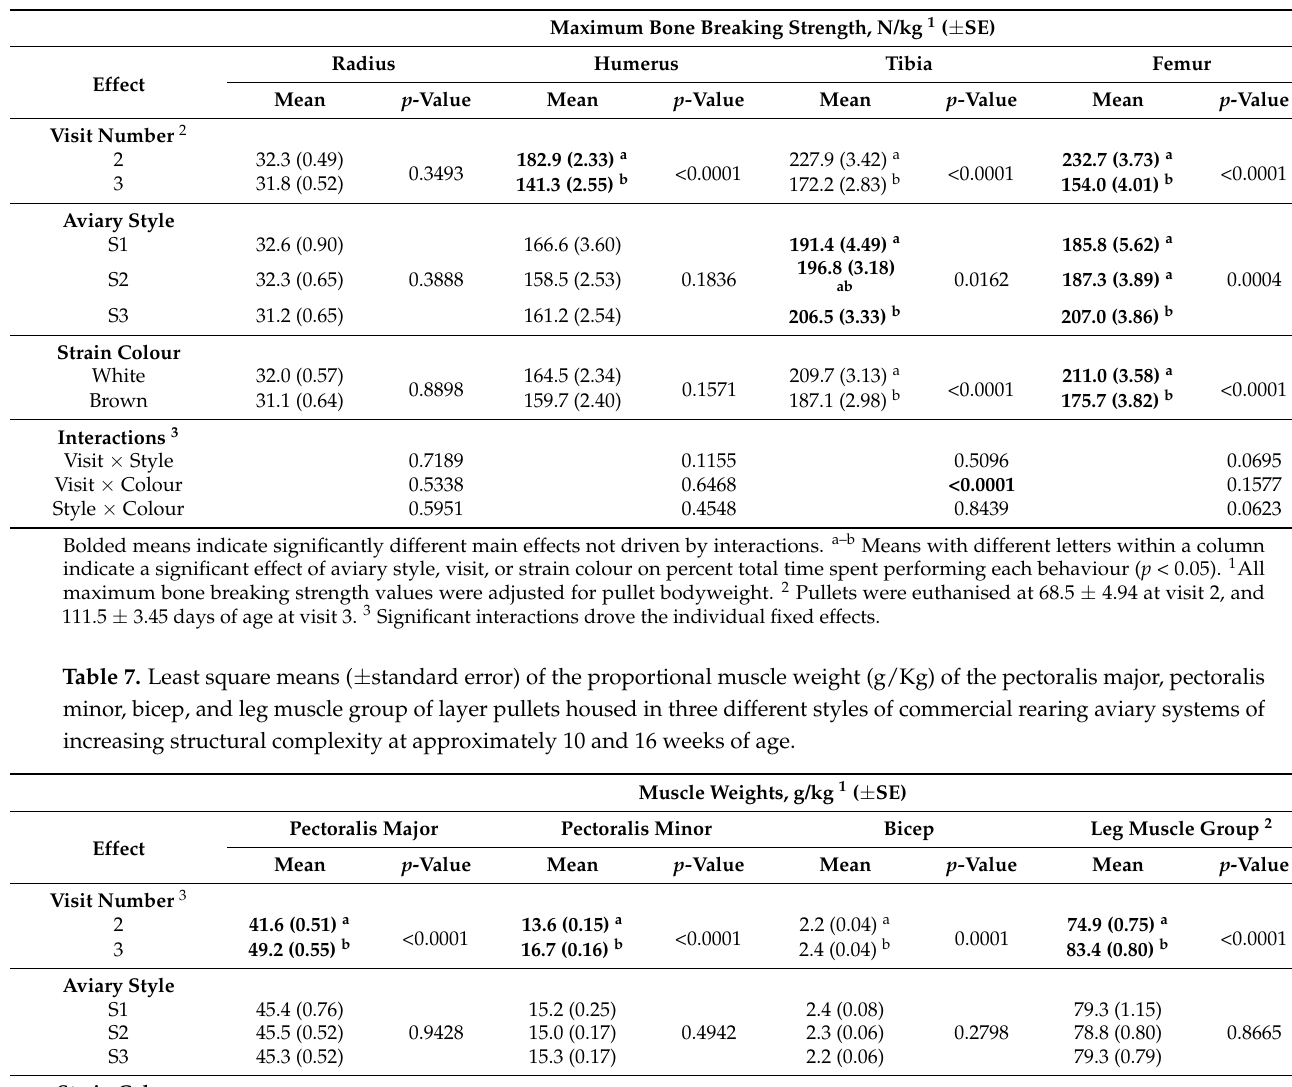
Table 6. Least square means ( ± standard error) of the maximum bone breaking strength (N/kg) of the radius, humerus, tibia, and femur of brown- and white-feathered strains of layer pullets housed in three different styles of commercial rearing aviary systems of increasing structural complexity at approximately 10 and 16 weeks of age.